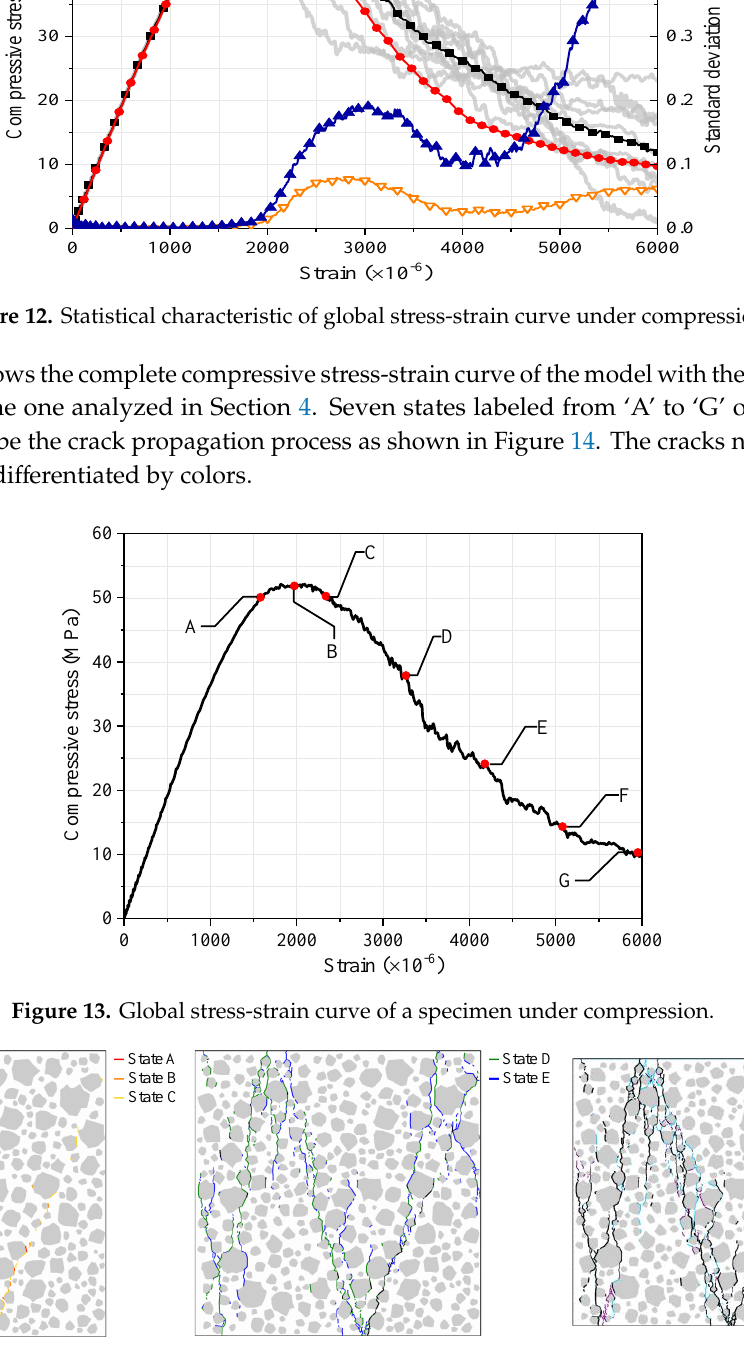
Figure 14. Crack propagation process of a specimen: ( a ) State A, B, C; ( b ) State D, E; ( c ) State F, G.